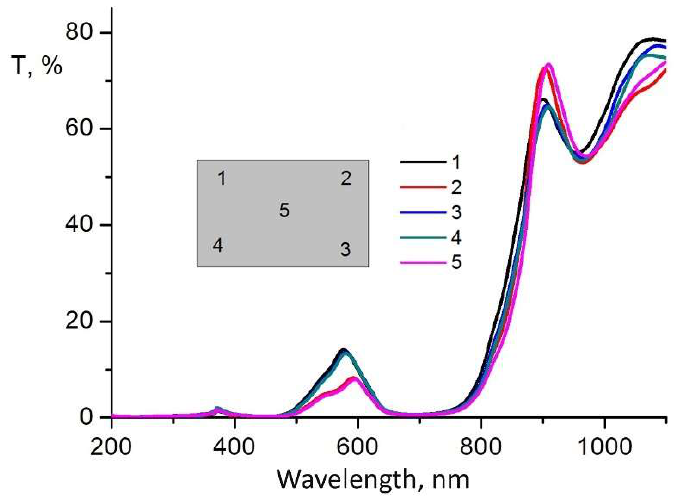
Figure 7. Optical transmittance in the ultraviolet and visible regions of the spectrum of samples with interference Si–SiO coating, formed on a sapphire substrate with dimensions of 150 × 80 mm at the investigated 1–5 zones.